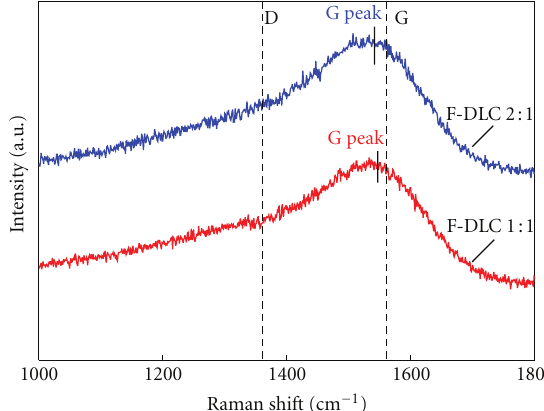
Figure 2: Raman spectra of the F-DLC